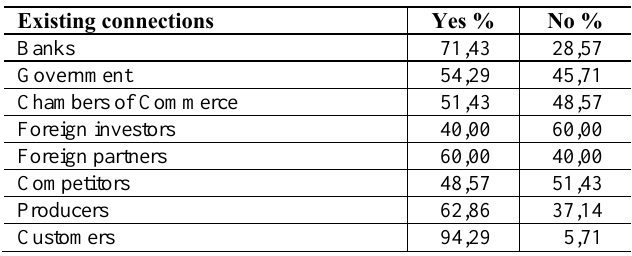
Table 5: Connections made possible through existing